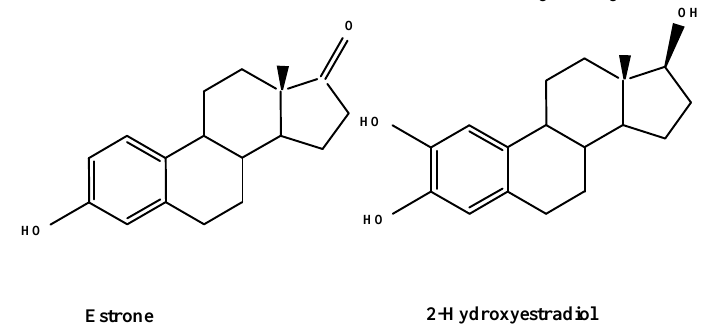
Figure 1. Chemical structures of estrone and